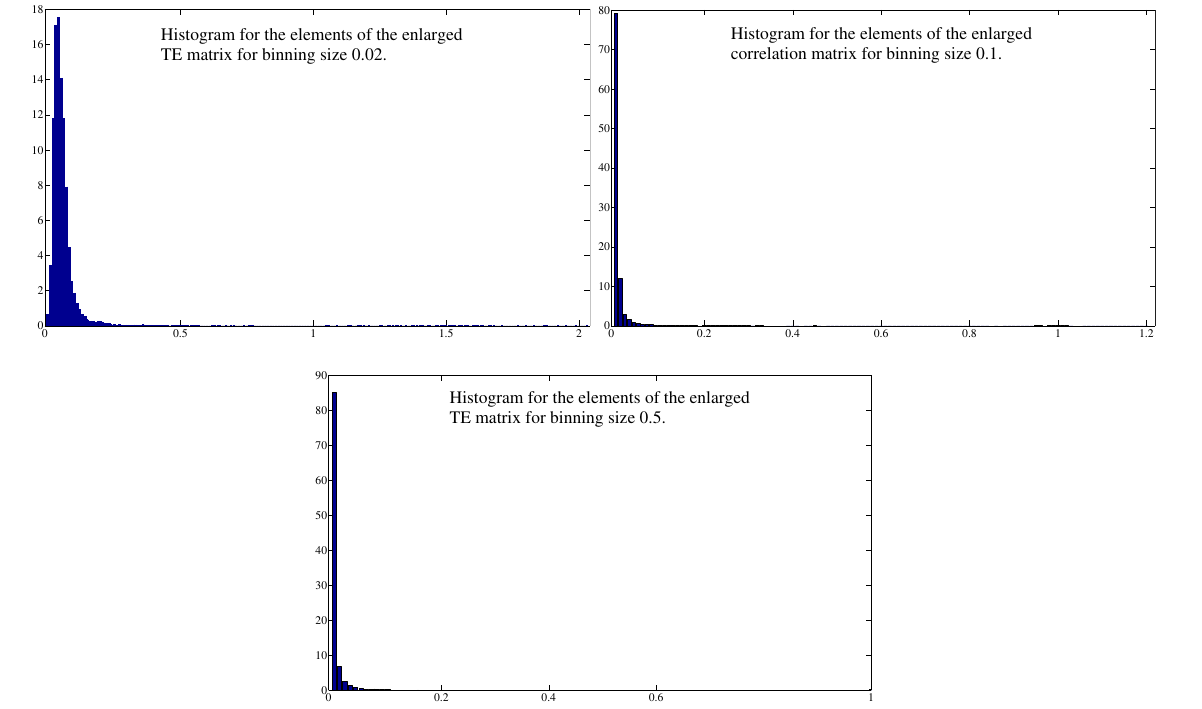
Figure 26. Histograms of the elements of the enlarged TE matrices obtained using three different binning sizes: 0 . 02 , 0 . 1 , and 0 . 5 ,